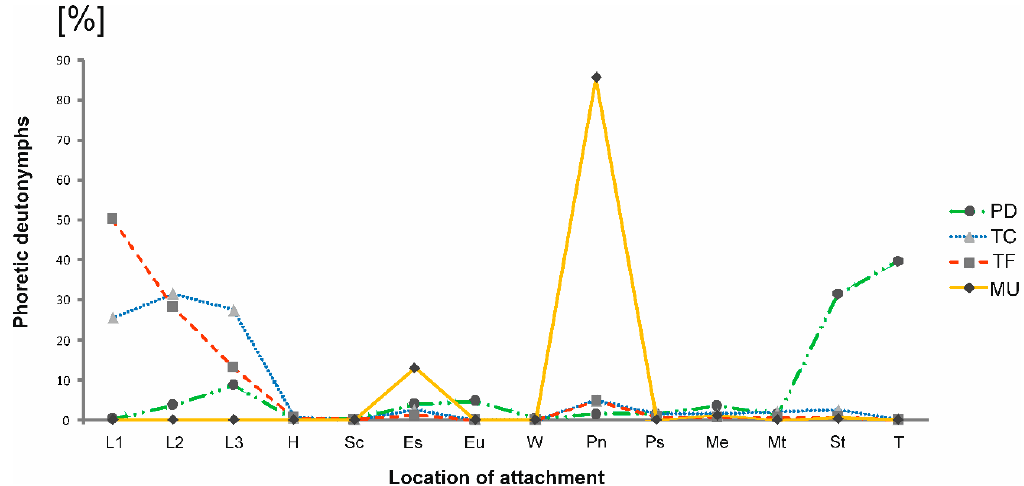
Figure 3. The proportion of phoretic deutonymphs on various parts of beetles’ body: ( PD ) Plagionotus detritus ; ( TC ) Tetropium castaneum ; ( TF ) Tetropium fuscum ; ( MU ) Monochamus sartor urussovii ; ( L1 ) forelegs; ( L2 ) midlegs; ( L3 ) hindlegs; ( H ) head; ( Sc ) scutellum; ( Es ) surface of the elytra; ( Eu ) subelytra; ( W ) membranous wings; ( Pn ) pronotum; ( Ps ) prosternum; ( Me ) mesoventrite; ( Mt ) metaventrite; ( St ) abdominal ventrites; ( T ) abdominal tergites. The colored lines serve as a guide to the eye.